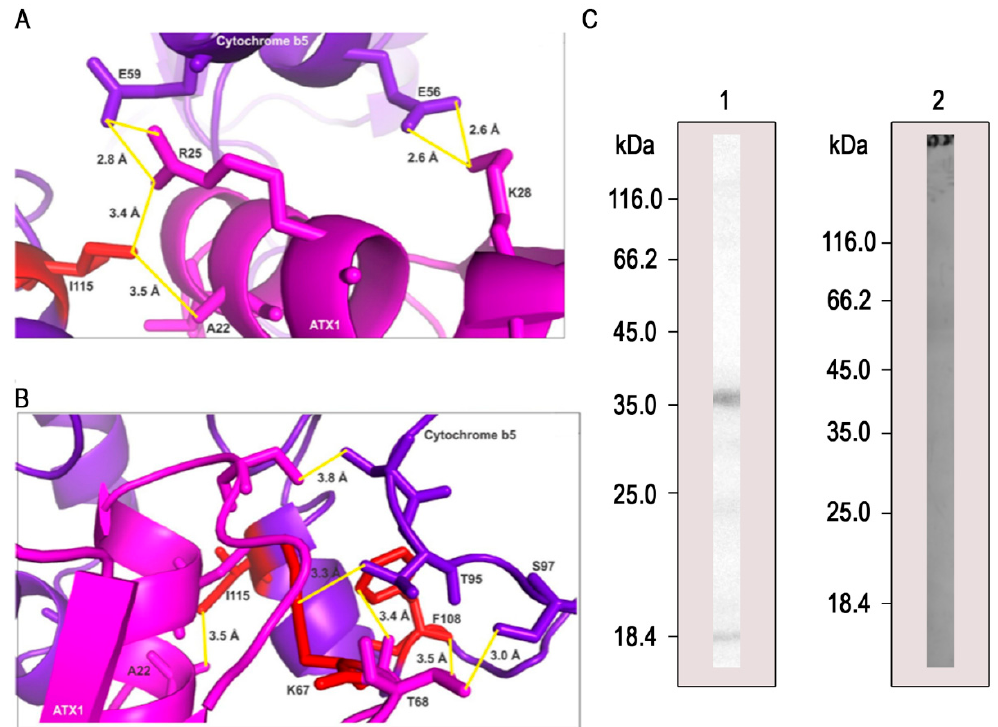
Figure 4. Interaction of Pb Atx1 and Pb Cyb5. ( A )—The hotspot residue I115 forms hydrogen bonds with A22 and R25, and neighboring residues E56 and E59 form hydrogen bonds with K28 and R25, respectively. ( B )—Residues K67 and F108 were also classified as hotspots and interact with residues present within the interface. This region contributes most, energetically, to the conformation of the complex once there are more hotspot residues and they are close to each other. Residues in red correspond to hotspots. ( C )—(1) Far-Western of 20 μ g of Pb Cyb5 fractionated by SDS-PAGE, transferred to a nitrocellulose membrane, and incubated with the purified Pb Atx1 (35 μ g/mL). (2) Negative control of BSA (60 μ g) also transferred to a nitrocellulose membrane and incubated with purified Pb Atx1 (35 μ g/mL). The interaction was detected with anti- Pb Atx1 polyclonal antibodies (1:500).